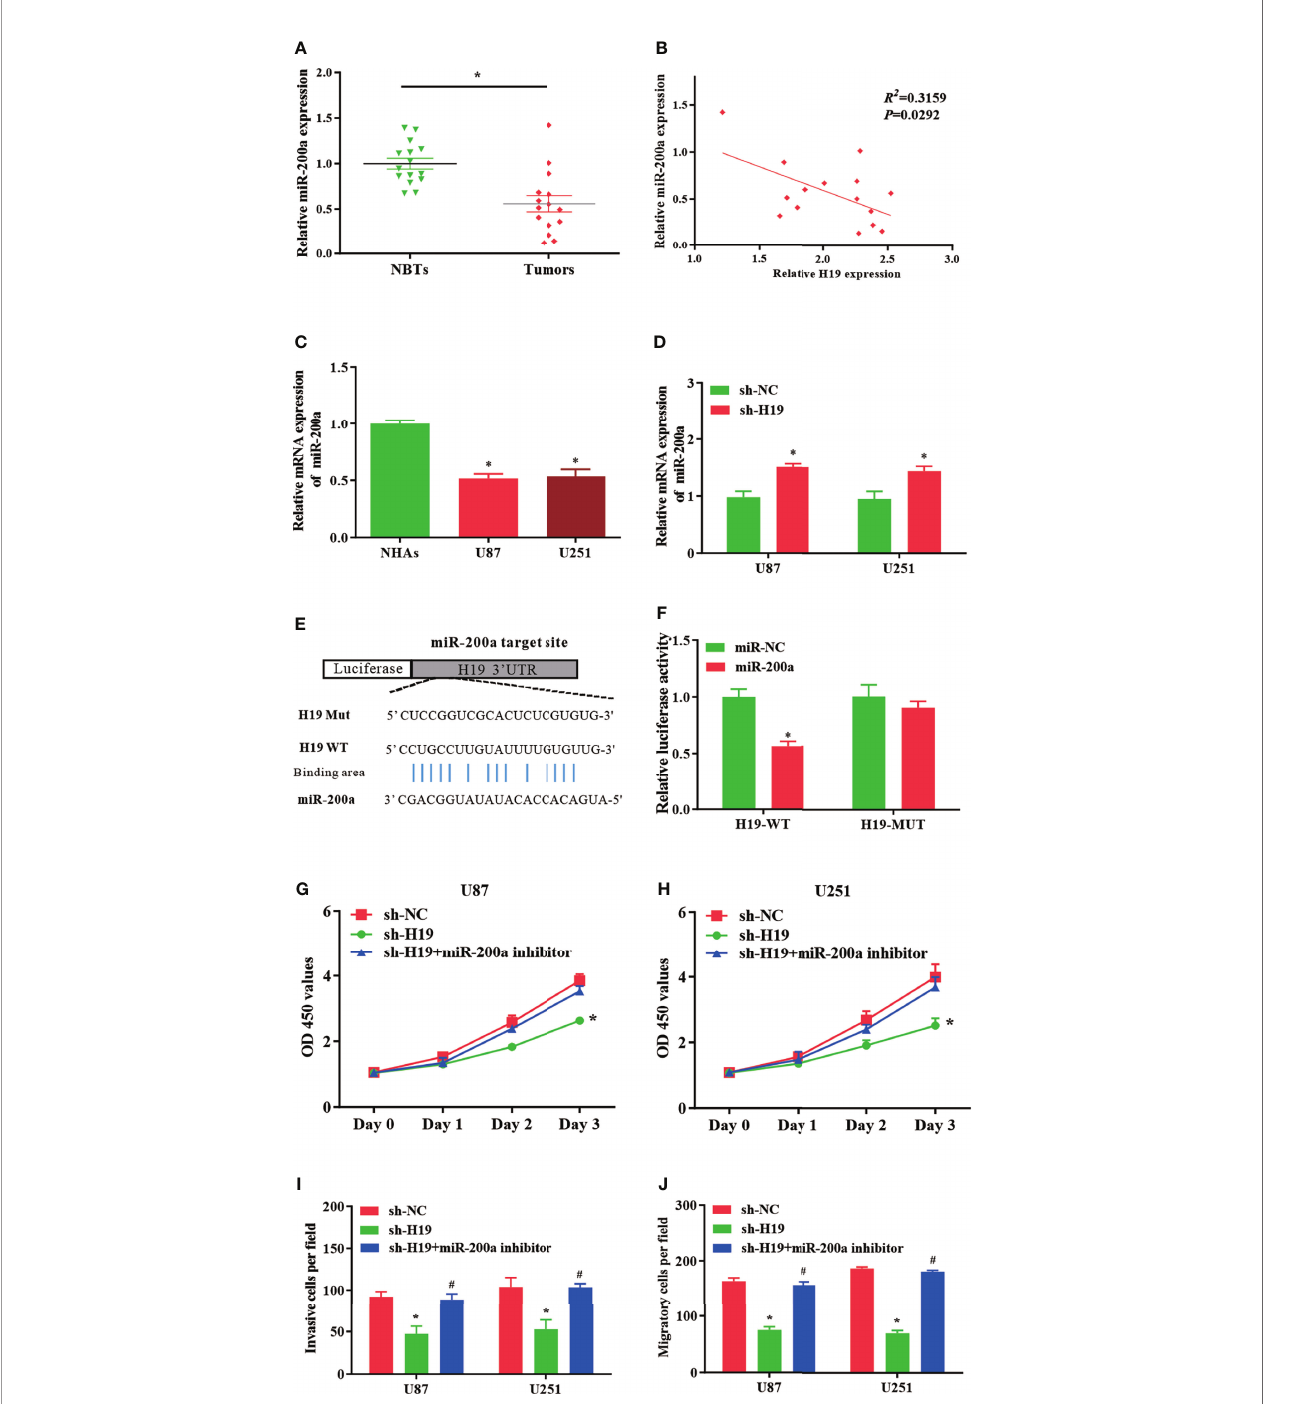
FIGURE 2 | MiR-200a is a putative target gene of H19 in glioma cells. (A) The expression levels of miR − 200a were examined in glioma tissues and paired para − tumorous controls using RT − qPCR. (B) The RNA levels of H19 and miR − 200a inversely correlated in glioma tissues (R 2 = 0.3159; P=0.0292). (C) The expression levels of miR-200a in normal human astrocytes (NHAs), U87-MG and U251 cells. (D) RT − qPCR was performed to evaluate the miR-200a expression in transfected U87-MG and U251 cells. (E) Potential binding sites between miR-200a and lncRNA H19 were predicted. (F) Overexpression of miR-200a decreased H19-WT- dependent luciferase activity, while H19-MUT-dependent luciferase signal remained unchanged. (G, H) The proliferation of transfected U87-MG and U251 cells was evaluated by CCK8 assay. (I, J) The invasion and migration of transfected cells were determined using Transwell assays. Data were presented as mean ± SEM; * P <0.05 vs NHAs or control group. # P <0.05 vs sh-H19 group. NHAs: normal human astrocytes. NBTs, normal brain tissues. NC, negative